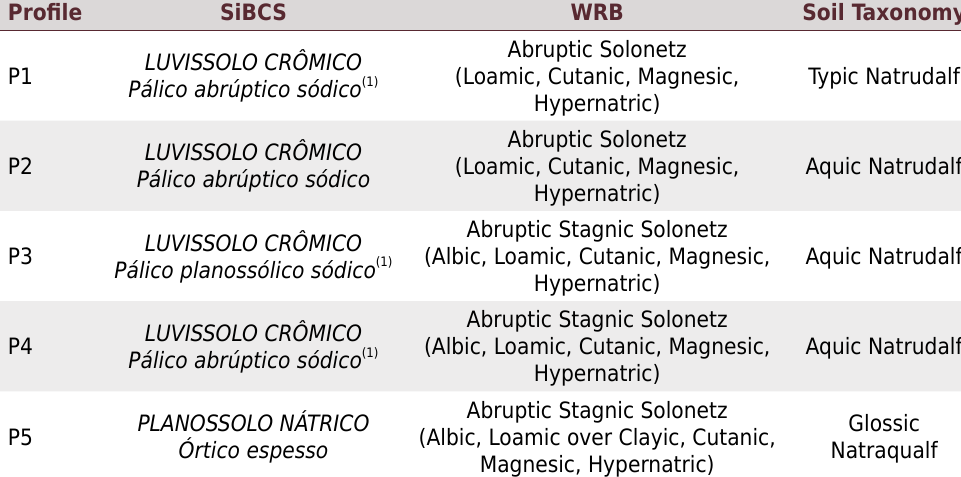
Table 6. Classification of soils studied according to the Brazilian Soil Classification System (Santos et al., 2013), FAO (WRB, 2014) and Soil Taxonomy (Soil Survey Staff, 2014)